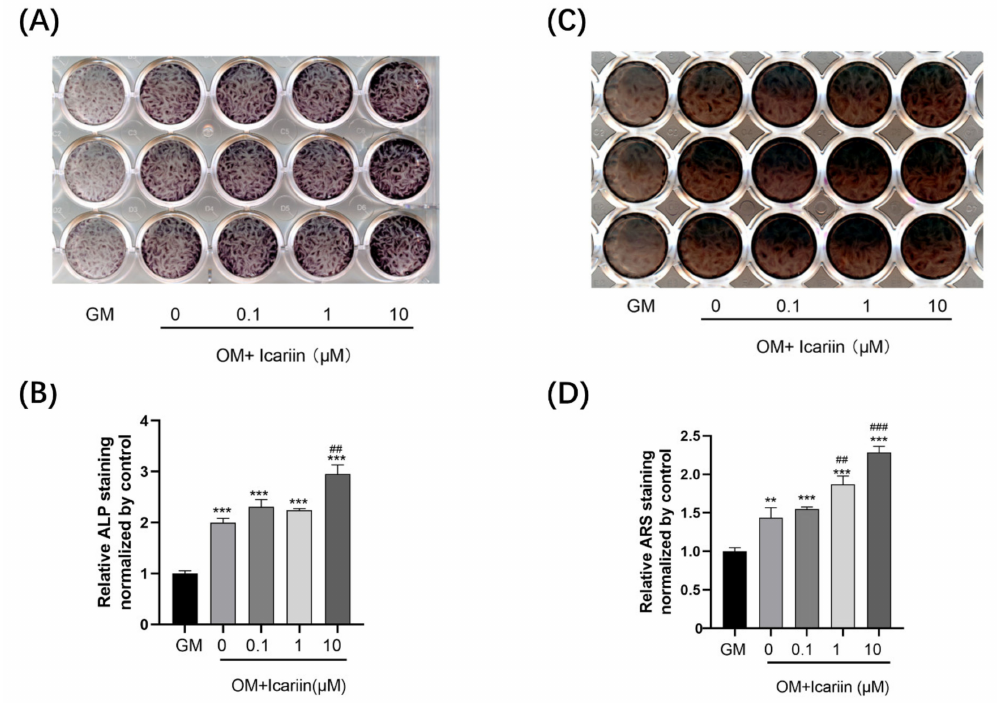
Figure 2. Mineralization of HDPCs after icariin treatment. ( A , B ) HDPCs were treated with different doses of icariin, displaying increased ALP activity at 10 days. ( C , D ) Treatment with icariin increased the capability of forming mineralized nodules on HDPCs at 14 days. Results were normalized to GM. Bars show means ± standard deviation (** p < 0.01 and *** p < 0.001 compared to GM; ## p < 0.01 and ### p < 0.001 compared to the OM without icariin treatment, ALP: alkaline phosphatase, ARS: alizarin red